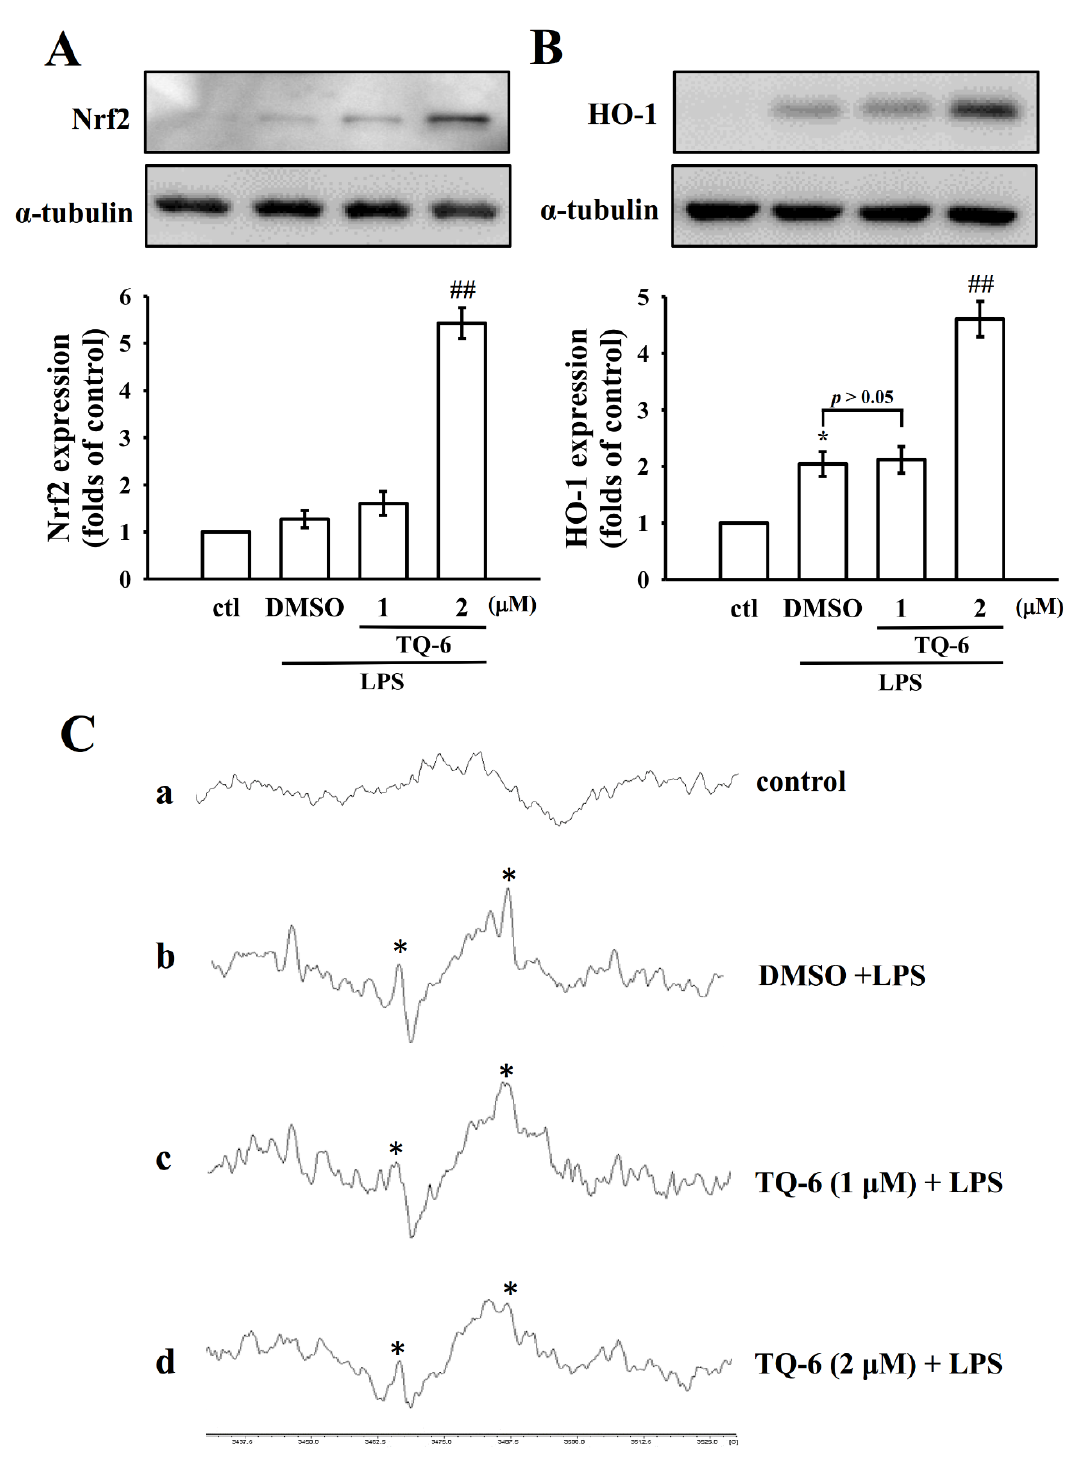
Figure 3. Effects of TQ-6 on Nrf2/HO-1 expression and OH • free radical formation in LPS-stimulated microglia. Cells were treated with 0.1% DMSO or TQ-6 (1 or 2 μM) for 30 min followed by LPS (1 μg/mL) for 24 h. The expression of ( A ) Nrf2 and ( B ) HO-1 was evaluated using an immunoblotting assay. ( C ) For another study, the cells were treated with ( a ) a control (0.1% DMSO), ( b ) 0.1% DMSO, or TQ-6 at ( c ) 1 μM or (d) 2 μM, followed by LPS (1 µg/mL) to trigger OH • formation. Profile C represents four independent experiments, and the asterisk (*) indicates OH • formation. Data are presented as mean ± SEM ( n = 4). * p < 0.05 compared with control (ctl); ## p < 0.01 compared with the LPS-treated cells.